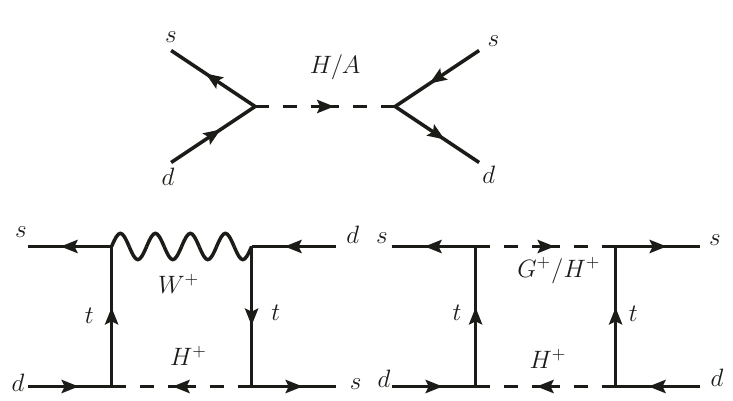
Figure 1 . Sketched Feynman diagrams for the (cid:1) S = 2